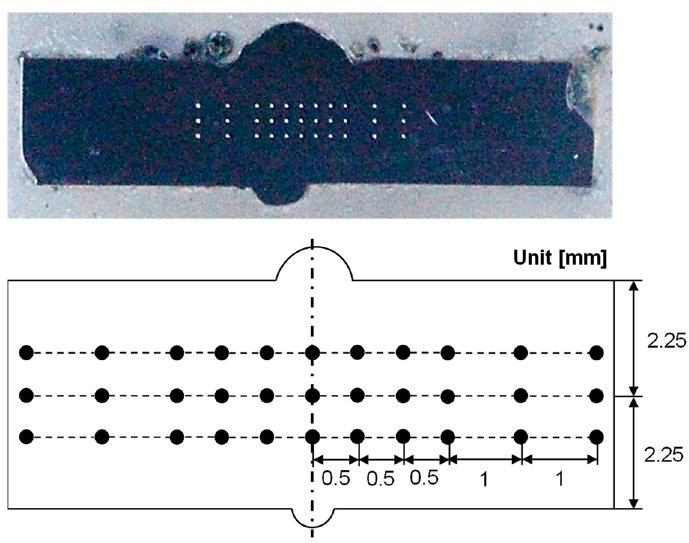
Figure 4. Vickers microhardness measurement points.